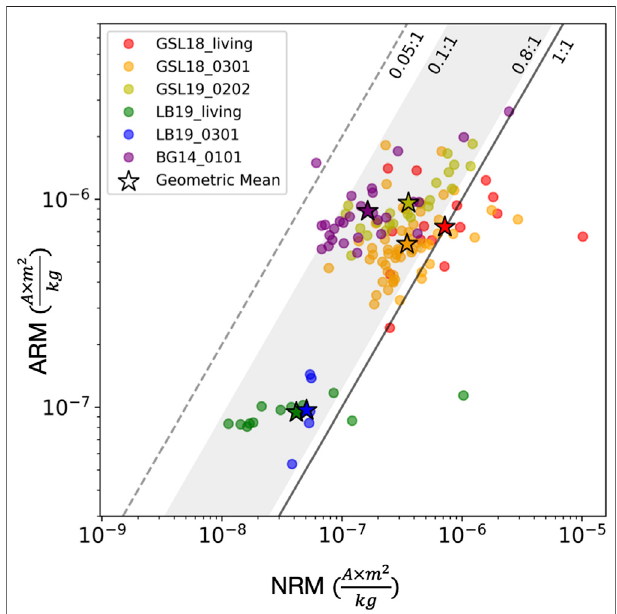
FIGURE 9 | NRM intensity ( x -axis) vs. ARM intensity ( y -axis) of microbialites on log scales. The sample group of GSL18_living (GSL18 living microbialites with cyanobacteria layer collected from Antelope Island Site 1, 2 and 4), GSL18_0301 (lithi fi ed microbialite from Antelope Island Site 3), GSL19_0202 (lithi fi ed modern microbialite from Lakeside Site 2), LB19_living (surface living microbialite samples collected from LB19 Site 1 and 3), LB19_0301 (lithi fi ed porous microbialite sample from LB19 Site 3), BG14_0101(CambrianBayanGolformationstromatolite)areshownwithred, orange, yellow, green, blue, and purple circles, and their geometric means are symbolized with stars. The black solid line represents NRM to ARM ratio of 1 (x (cid:1) y ), and measurements plotted on the left side of this line (ARM >> NRM) isconsistentwithaDRMorigin.ThegrayshadingshowstheNRM/ARMrange of clastic sediments (0.1 – 0.8) (e.g., Levi and Banerjee, 1976; Constable, 1985), and the gray dashed line represents the maximum constraint for biogenic magnetite (0.05) (e.g., Roberts et al., 2012; Rodelli et al., 2019).